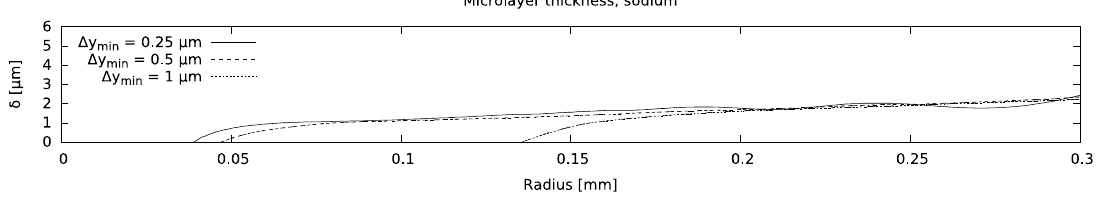
Figure 10. Microlayer thickness modelled with increasingly refined computational meshes. Table 4. Parametric study on microlayer